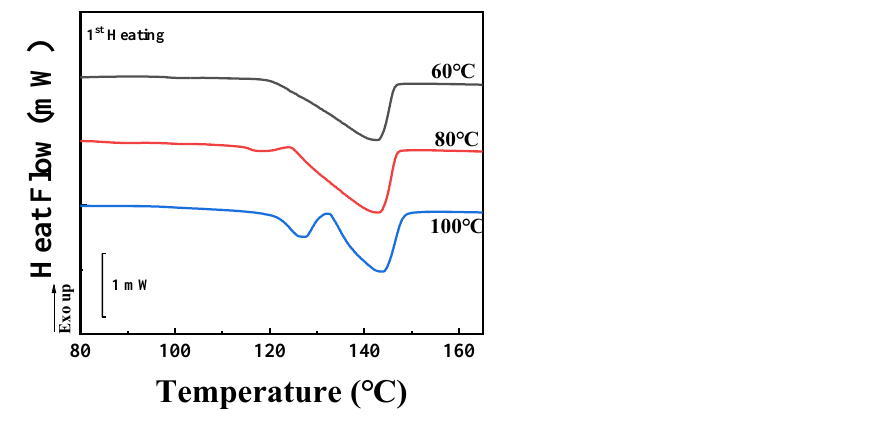
Figure 6. DSC heating curves of the PLLA/TAIC (60/40) blend upon complete cold crystallization at the indicated temperatures. Table 2. Long period, thickness of lamellae, amorphous layer, crystallinity from SAXS and DSC upon cold crystallization at the indicated temperatures.